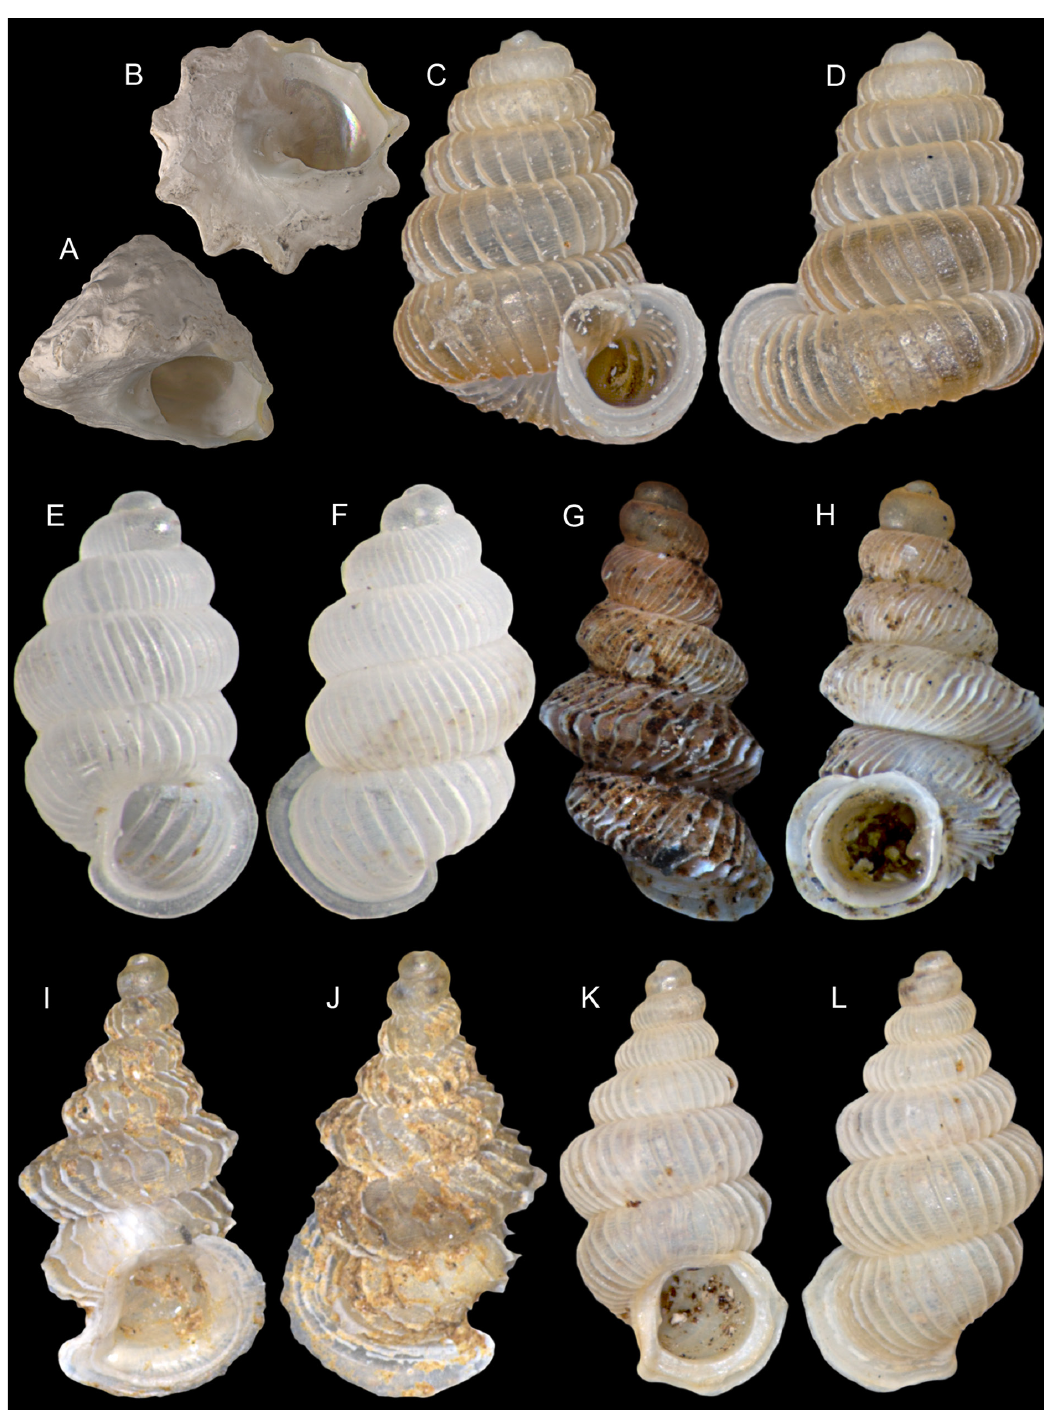
Fig. 1. A–B . Astraea danieli Alf & Kreipl, 2006, paratype MZSP 95919, L = 11.5 mm, W = 14.5